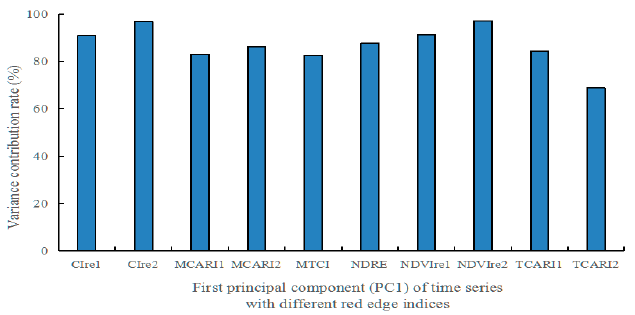
Figure 3. Variance contribution rate of PC1 about 10 different red edge indices time series. Table 6. Red edge index features importance score based on SDA and RF.